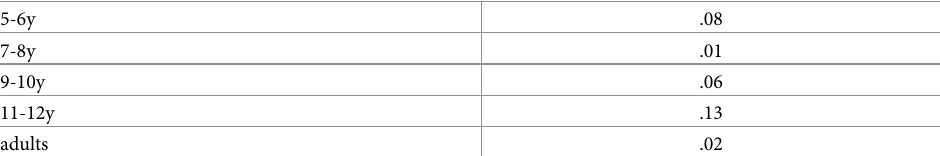
Table 3. Correlation coefficients between voice response rates in incongruent trials for the two tasks in each age